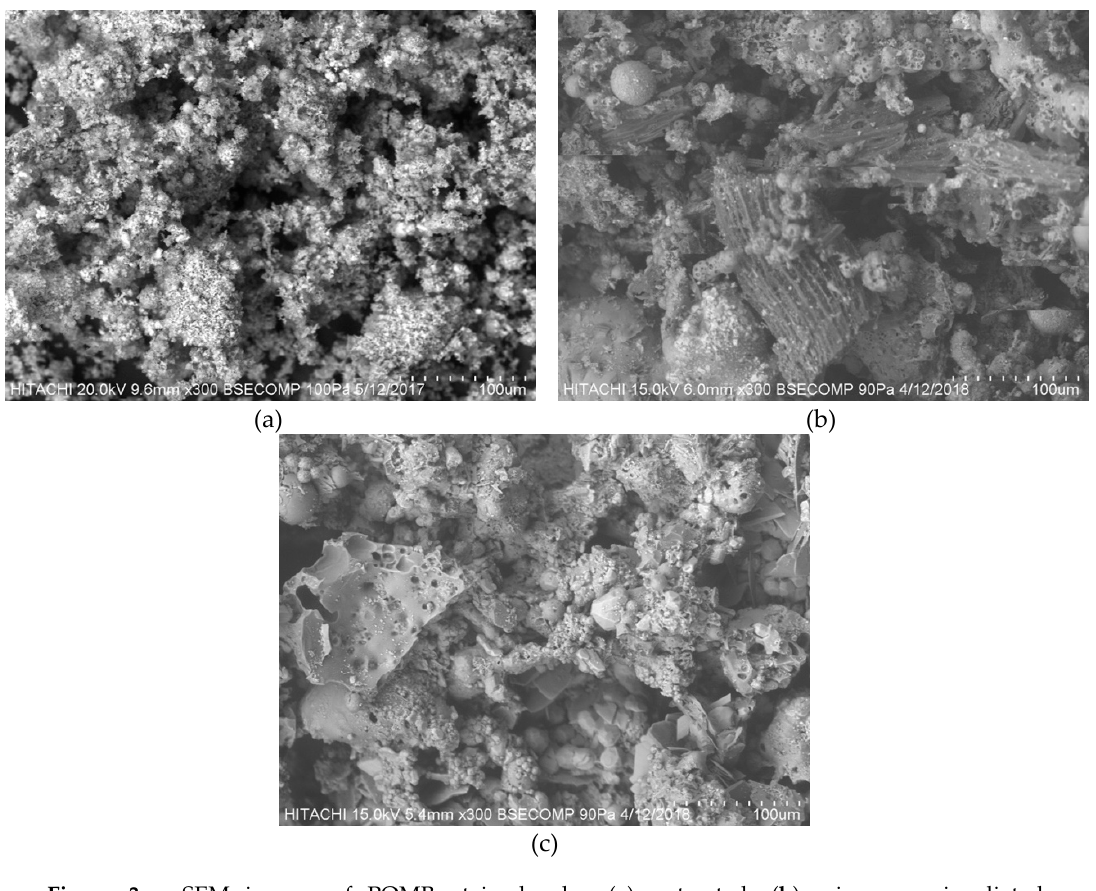
Figure 3. SEM images of POMB-retained ash: ( a ) untreated, ( b ) microwave irradiated, ( c ) H 2 SO 4 – microwave irradiated.